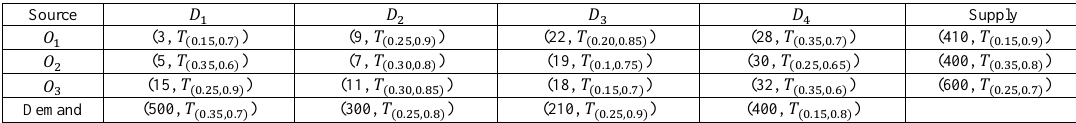
Table 1. Data for transportation cost, supply and